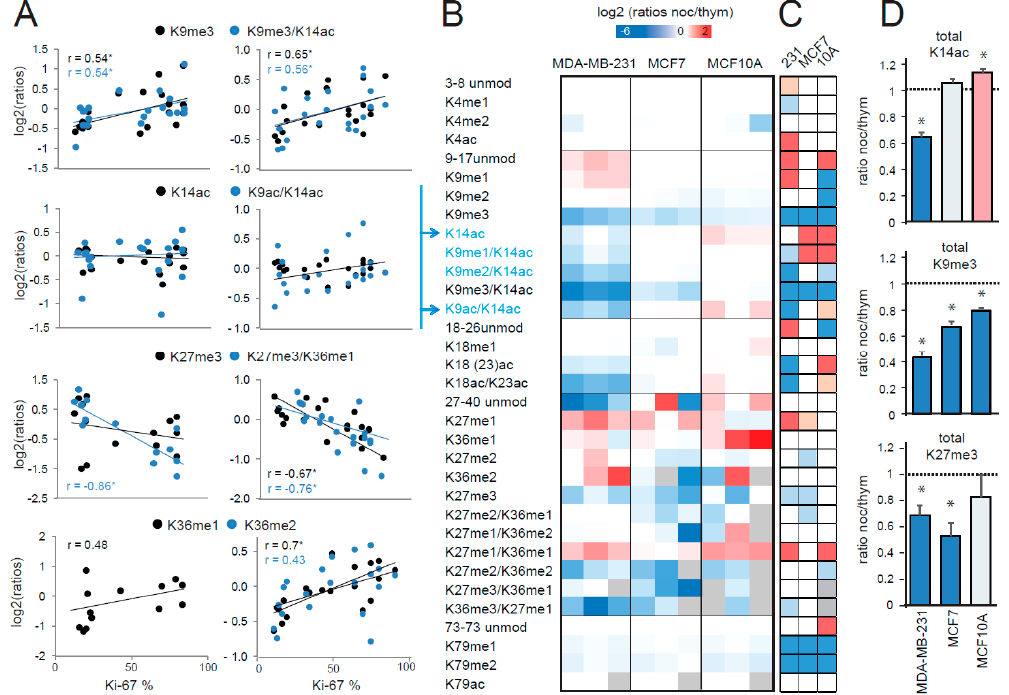
Figure 2. Correlation of histone post-translational modifications (PTMs) and proliferation rate. ( A ) L / H (light / heavy) ratios for the indicated peptides were plotted against the Ki-67 proliferation index for the frozen breast cancer patient samples analyzed in this study and are shown in Figure 1A, C (left panel), or breast cancer FFPE samples analyzed in [15] (right panel, containing luminal A-like, luminal B-like, HER2 (human epidermal growth factor receptor 2) positive, and triple negative subtypes). The Pearson’s correlation score (r) is shown when above 0.4 and an asterisk indicates a correlation with a p value < 0.05. ( B ) Heatmap display of the log2 transformed ratios obtained for the indicated histone H3 PTMs for the MDA-MB-231 and MCF7 breast cancer cell lines and the MCF10A normal breast cell line. “Ratios of ratios” are shown, which were obtained by dividing the L / H ratios for nocodazole-treated cells (synchronized in G2-M phase) by the L / H ratio for thymidine treated cells (synchronized in G1-S phase). The grey color indicates peptides that were not quantified. Peptides containing K14ac are highlighted in blue. ( C ) Modified peptides in nocodazole- and thymidine-synchronized cells were compared by paired t -test. The red color indicates an increase in G2-M phase, the blue color a decrease ( p < 0.05 for darker colors, p < 0.1 for lighter colors). The grey color indicates peptides for which enough data points to obtain a p -value were not available. ( D ) Histograms representing the ratios of nocodazole- and thymidine-treated cells for total H3K14ac (given by the sum of H3K14ac, H3K9me1 / K14ac, H3K9me2 / K14ac, H3K9me3 / K14ac, and H3K9ac / K14ac), total H3K9me3 (given by the sum of H3K9me3 and H3K9me3 / K14ac), and total H3K27me3 (given by the sum of H3K27me3 and H3K27me3 / K36me1) for the three cell lines tested. Changes in nocodazole-compared with thymidine-treated cells are indicated by an asterisk (*: p < 0.1). The red color indicates an increase in G2-M phase, while the blue color indicates a